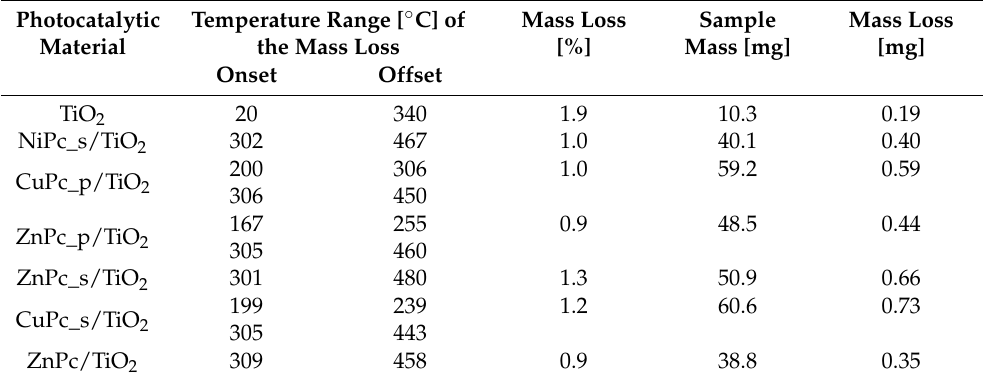
Table 4. Results of the TG-DSC analysis for each photocatalytic composite. The mass loss temperature ranges were determined based on the data shown in Figure